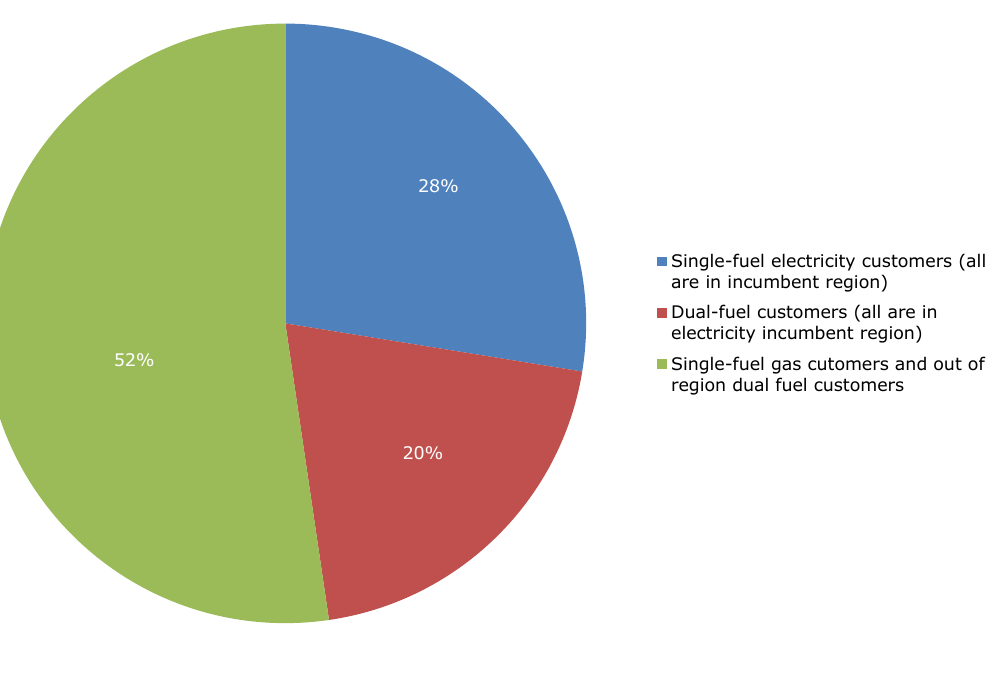
Figure 18: Composition of legacy electricity suppliers’ customer bases